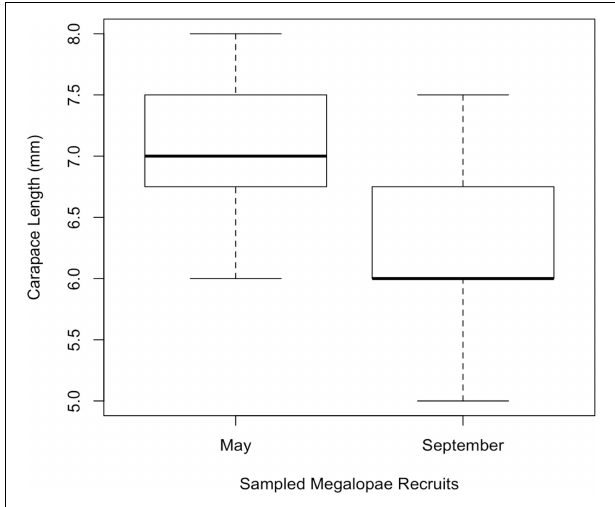
FIGURE 4 | Mean carapace length of megaloape recruits sampled for genomic analysis from Coos Bay in May (expected-season; n = 47) and September (late-season; n =